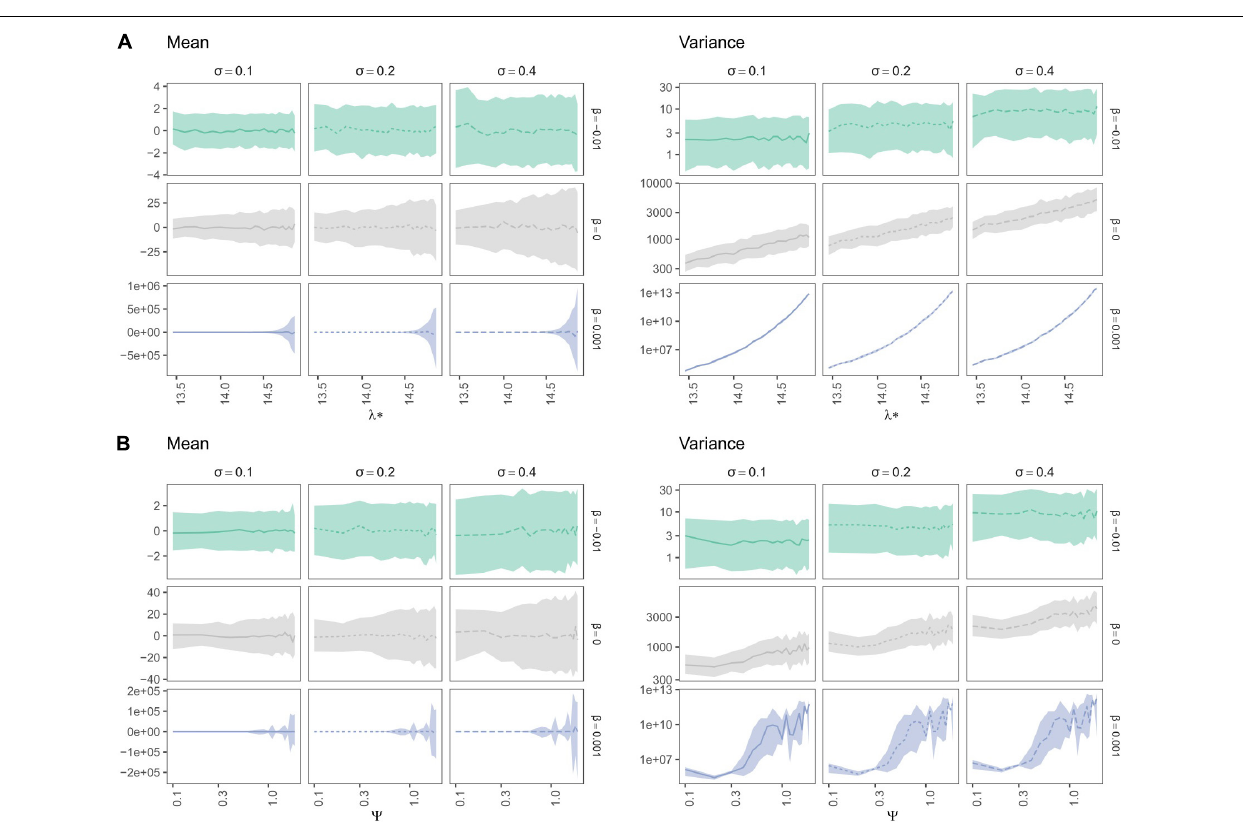
FIGURE 8 | Variation in median trait moments (mean and variance) as well as their interquartile ranges (IQR) along the ln-transformed principal eigenvalue ( λ *) (A) and skewness ( ψ ) (B) , summarizing the variation in simulated spectral density profiles according to the parameters used to simulate trait evolution ( β in rows and σ in columns in each individual panel). The lines represent the median over 100 replications of trait evolution models and are dashed according to sigma values, while the shaded area represents the replicates’ interquartile ranges (IQR). Species richness is fixed for all simulations ( S = 31). Brownian Motion is represented in grey, while Early and Late Burst are shown respectively in green or